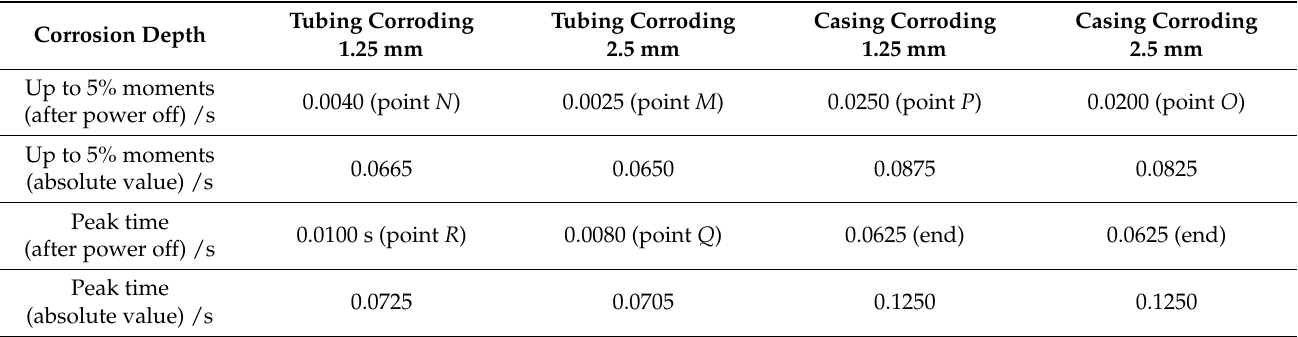
Table 2. 5% time and peak time of sensitivity time slice curves for different